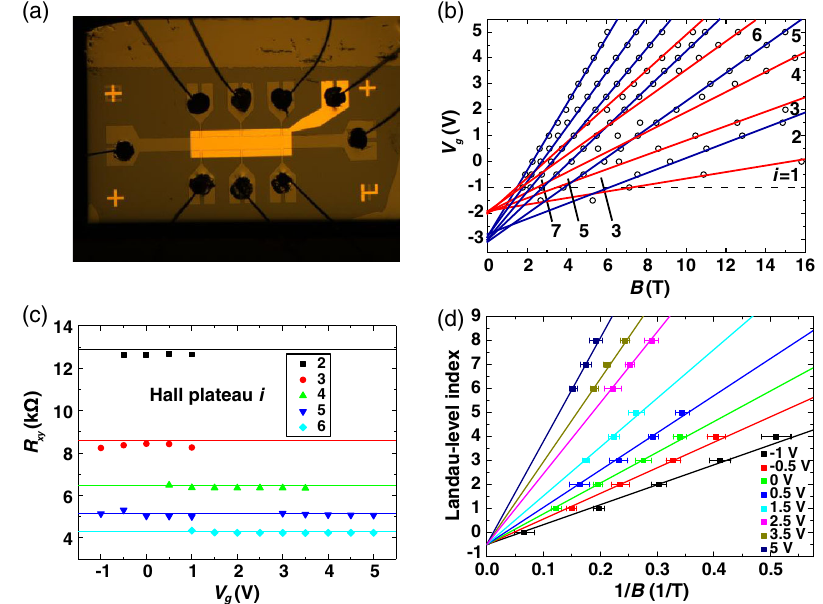
FIG. 3. (a) Micrograph of the sample used in the experiments. (b) Landau-fan plot summarizing the data of Fig. 1. The open circles are the field and gate-voltage positions where the Landau levels cross the Fermi energy; the red and blue lines indicate the two separate Landau fans connecting the observed Fermi-level crossings. The numbers give the quantum Hall plateau i that can be observed in this part of the diagram. (c) The accuracy of the Hall quantization for various plateaus and gate voltages (the drawn lines indicate perfect quantization). (d) The Landau-level index at various gate voltages as a function of inverse magnetic field. The high-field cutoff gives the Berry phase induced by the Dirac band